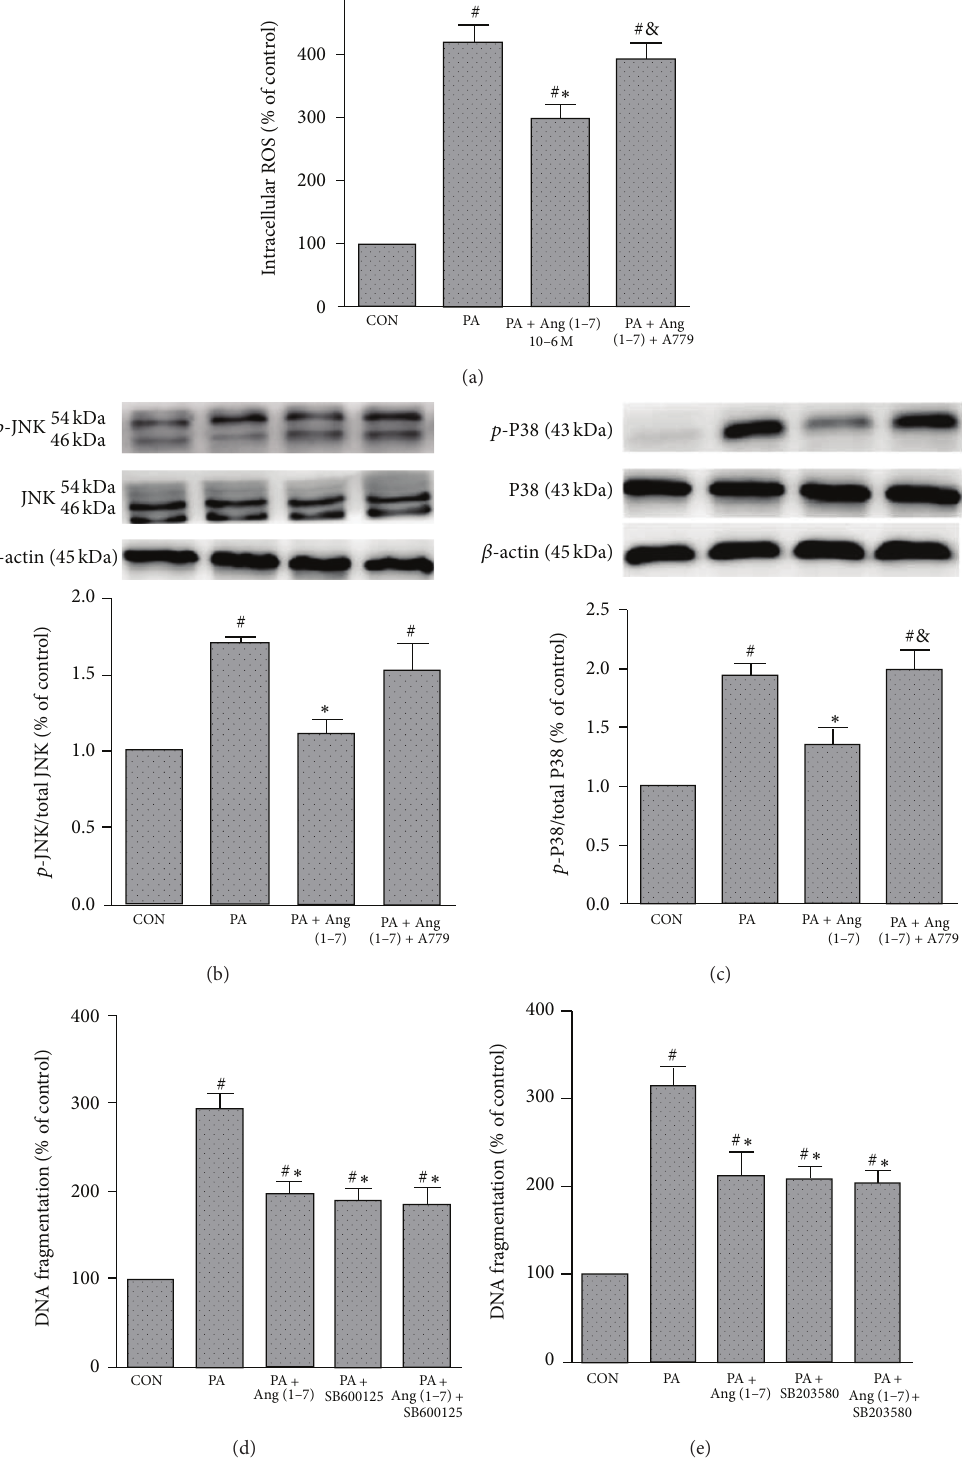
Figure 5: Effect of JNK and P38 pathway on antilipoapoptosis effect of Ang (1–7). Cells were incubated in palmitate (0.25 mmol/L) for 24 h with or without Ang (1–7) (10 −6 mol/L), A-779 (10 −5 mol/L), the JNK inhibitor SP600125 (2 × 10 −5 M) or the p38 MAPK inhibitor SB203580 (10 −5 M). ROS production (a), JNK phosphorylation (b), P38 phosphorylation (c), and DNA fragmentation were measured (d, e). Values are mean ± SEM, 𝑛 = 3 for each group. # 𝑃 < 0.05 versus CON; ∗ 𝑃 < 0.05 versus PA; & 𝑃 < 0.05 versus PA + Ang